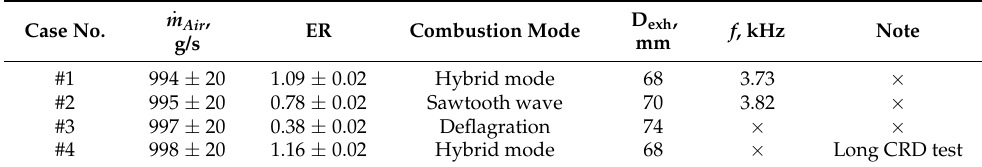
Table 1. Typical experiments with different combustion modes.